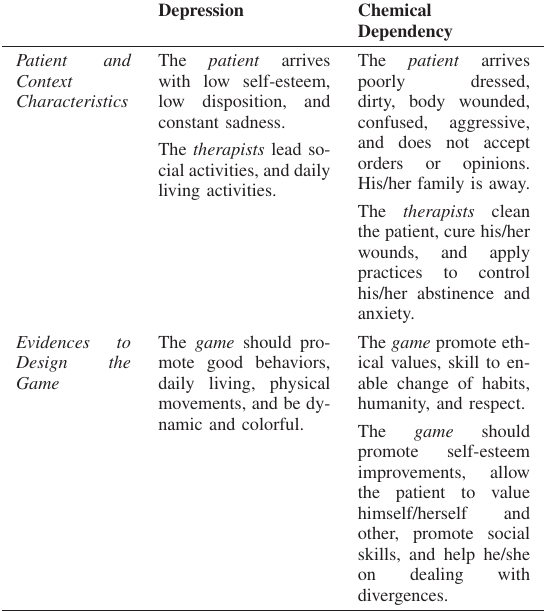
TABLE II E XAMPLES OF CHARACTERISTICS OF THE CONTEXT AND OF THE PATIENTS (P ERSONAS ), AND EVIDENCES FOR THE GAME ’ S DESIGN